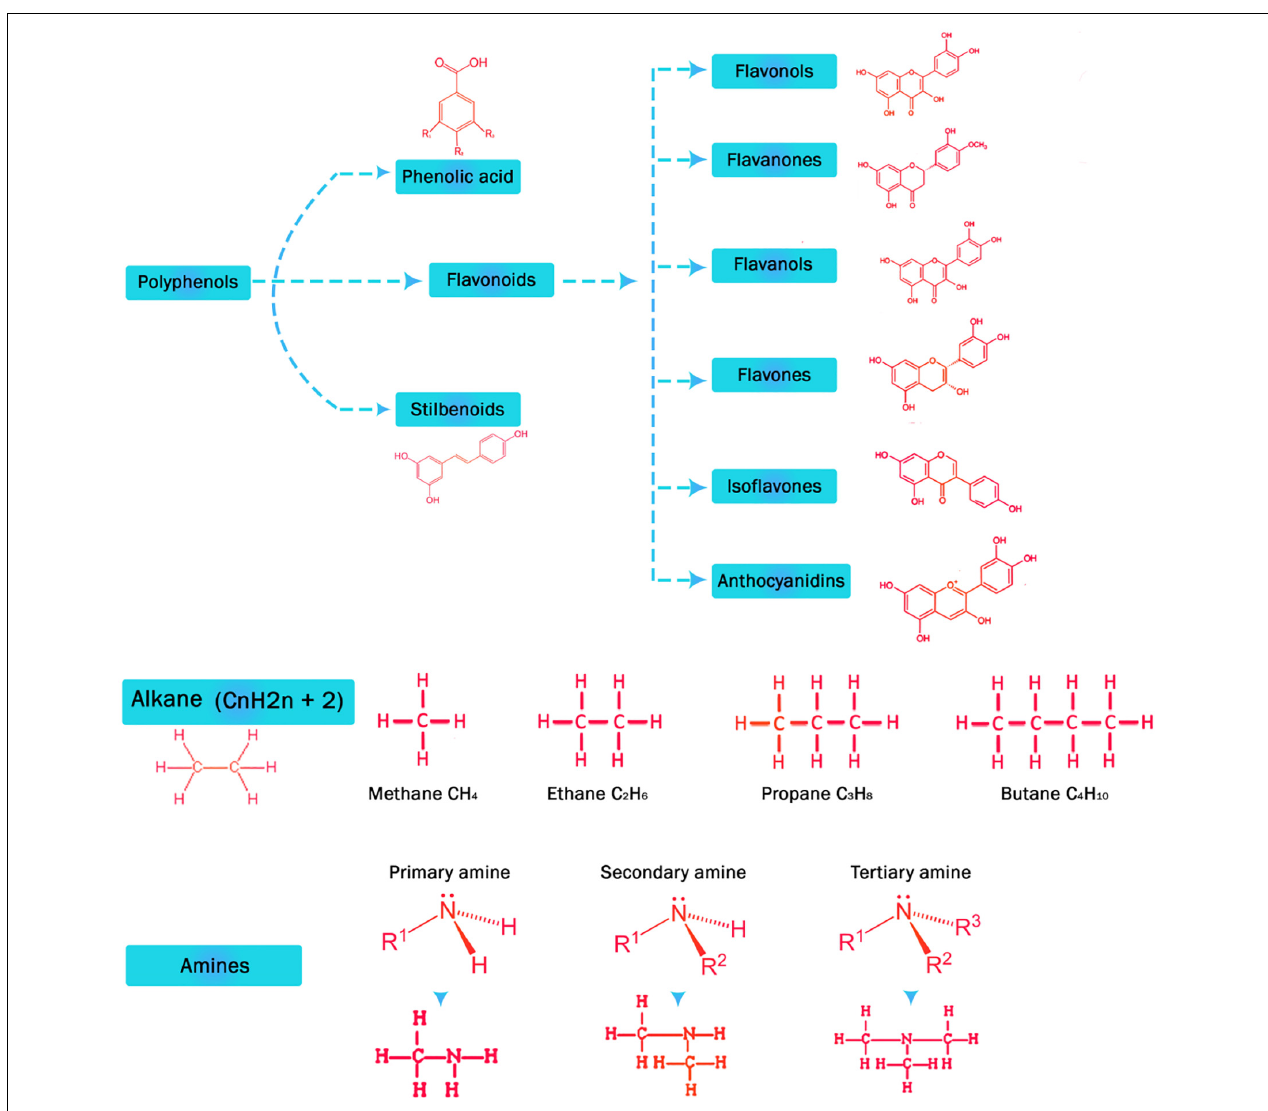
FIGURE 5 | Role of polyamines in various physiological processes occurring in plants regulate defense pathways and their cascade of tolerance to heavy